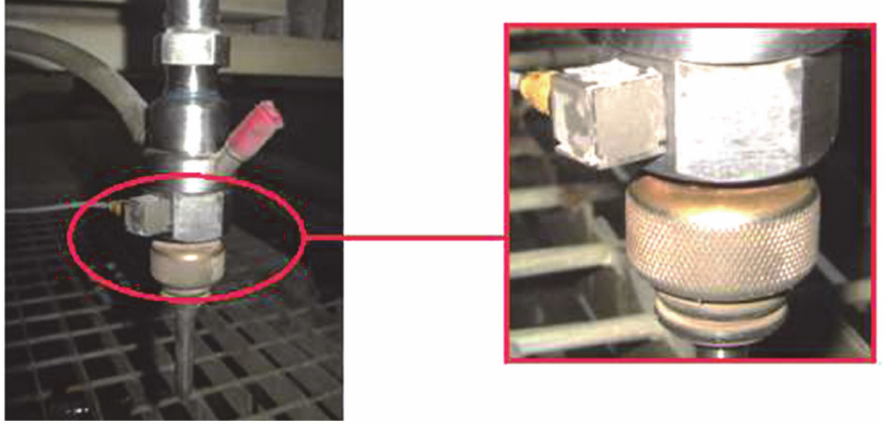
Figure 3. Detailed image of the mounting of a miniature vibration acceleration sensor on the technological